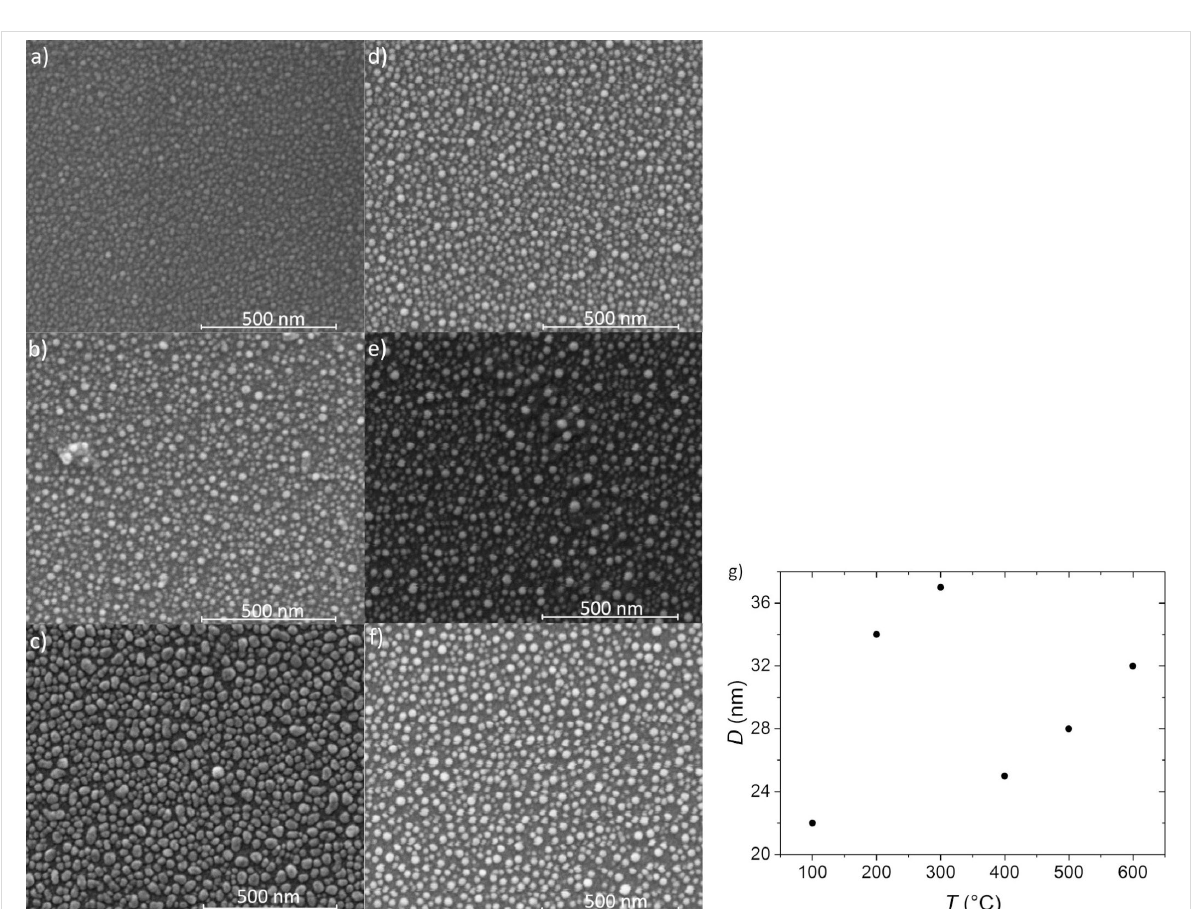
Figure 7: SEM images of a 2.8 nm thick film, annealed for a constant time 15 min at different temperatures: (a) 100 °C, (b) 200 °C, (c) 300 °C, (d) 400 °C, (e) 500 °C and (f) 600 °C; (g) average nanostructure diameter as a function of the annealing